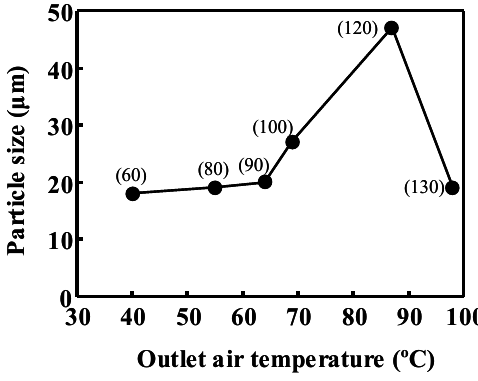
Figure 6. Effect of outlet air temperature on the powder size. The wall matrix is the equal-mass mixture of mannitol and